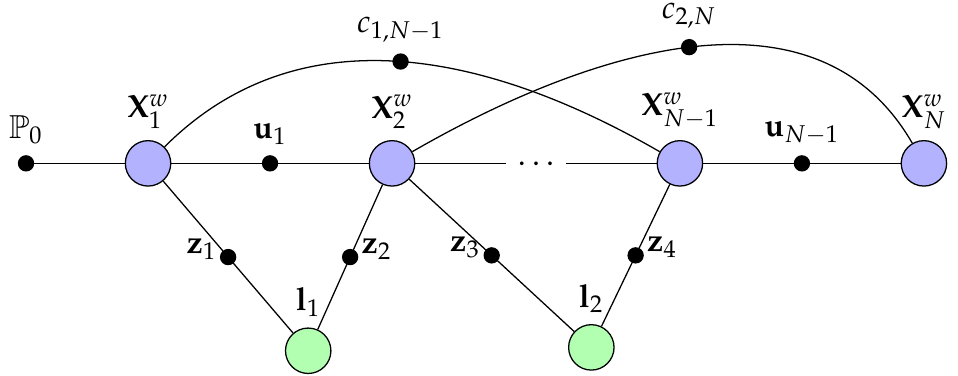
Figure 2. Visual-SLAM Bundle Adjustment (BA) in a factor graph. The potential odometry factor u i constrain the relative camera poses with potential loop-closure factors c i of the camera poses. This figure demonstrate loop-closure factors c 1, N and X w , and c 2, N between X w and X w for deciding whether the mobile robot had returned to X w 2 1 1 N N − a previously visited area.